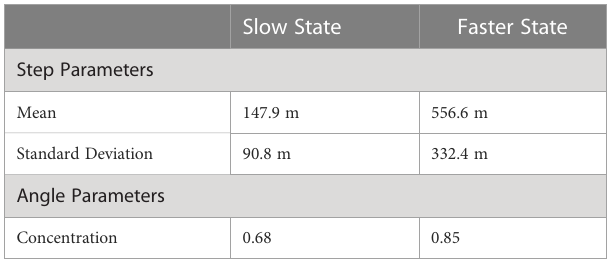
TABLE 1 Model parameters with 5 min steps for the delayed wind model (highest ranking AIC).